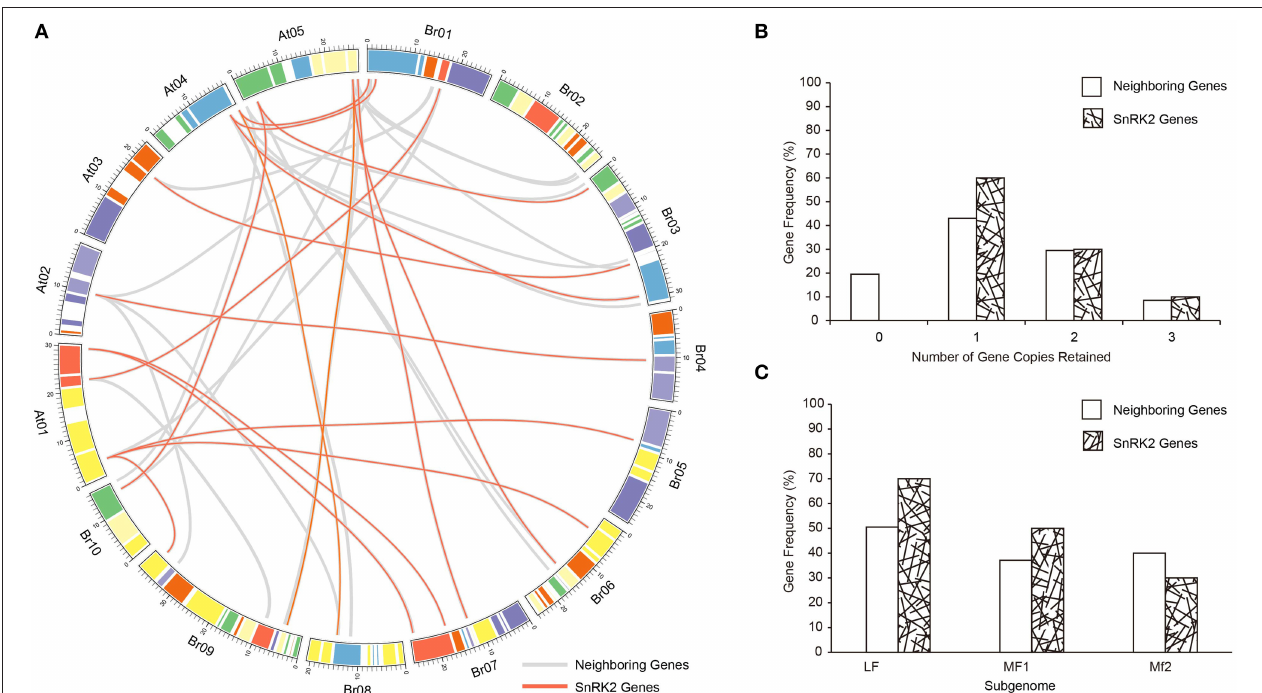
FIGURE 3 | Retention of SnRK2 genes and neighboring genes (10 flanking genes on either side of the clock gene) in B. rapa. (A) Collinear correlations of SnRK2 genes and neighboring genes in the A. thaliana and B. rapa genomes. The B. rapa and A. thaliana chromosomes are colored according to the inferred ancestral chromosomes following an established convention. The lines of SnRK2 genes are red and neighboring genes are gray. The figure was created using Circos software. (B) Retention by number of homoeologous copies in the syntenic region. (C) Retention of homoeologs among the three subgenomes of B. rapa